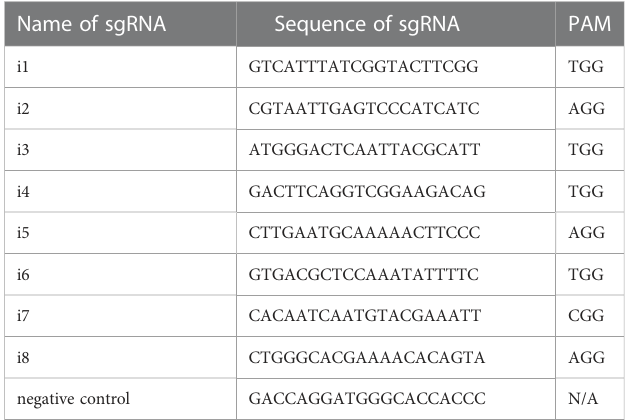
TABLE 1 Sequences of